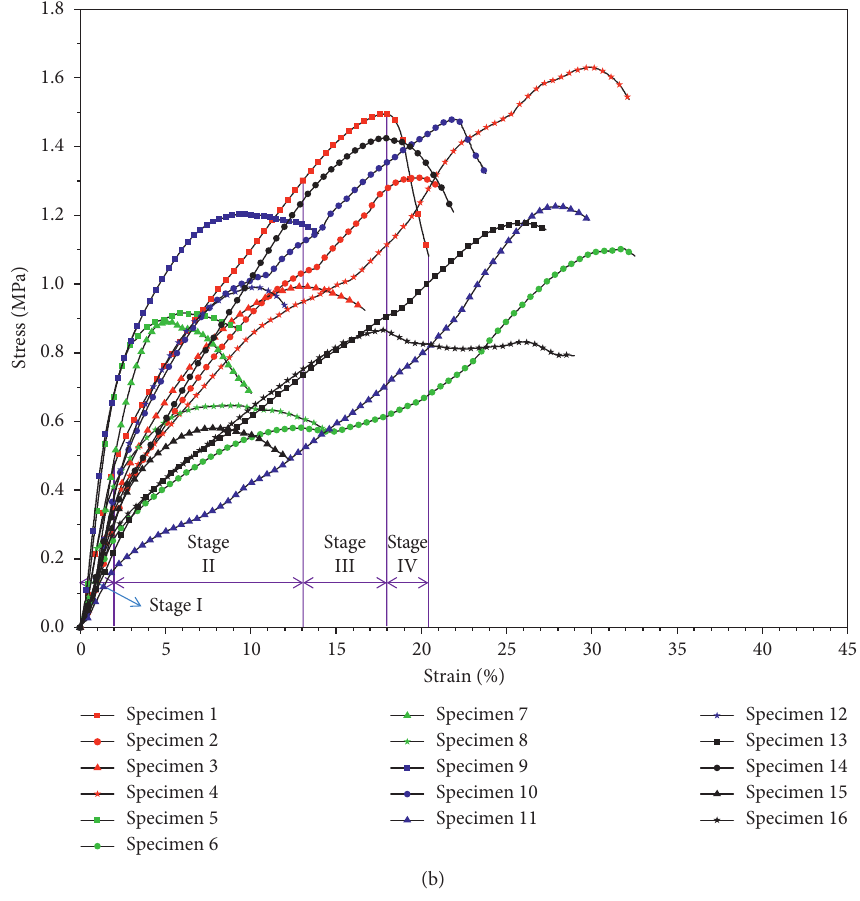
Figure 6: The stress-strain curves of specimens under uniaxial compression. (a) CCS and (b) CFS.